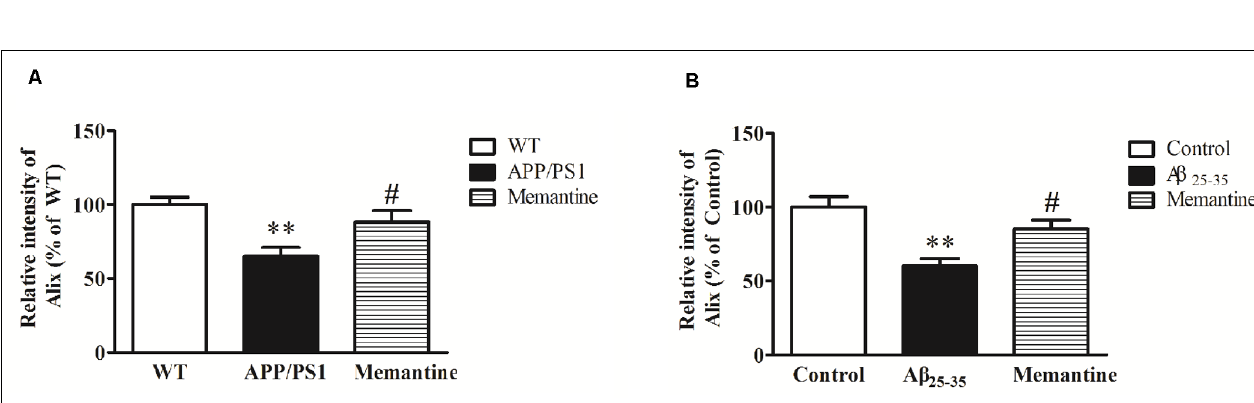
FIGURE 6 | (A) Western blot analysis of Alix after the treatment of Memantine in serum samples from APP/PS1 mice and wild-type (WT) mice. Quantified results were normalized to IgG expression. Values were expressed as percentages compared to WT group (set to 100%), and represented as means ± SEM. n = 8–10. ∗∗ p < 0.01 vs. the WT group, # p < 0.05 vs. APP/PS1 mice. (B) Western blot analysis of Alix after the treatment of Memantine in serum samples from A β intracerebroventricular-injected rats and age-matched controls. Values were expressed as percentages compared to the control group (set to 100%), and represented as means ± SEM. n = 8–10. ∗∗ p < 0.01 vs. the control group, # p < 0.05 vs. A β 25–35 intracerebroventricular-injected